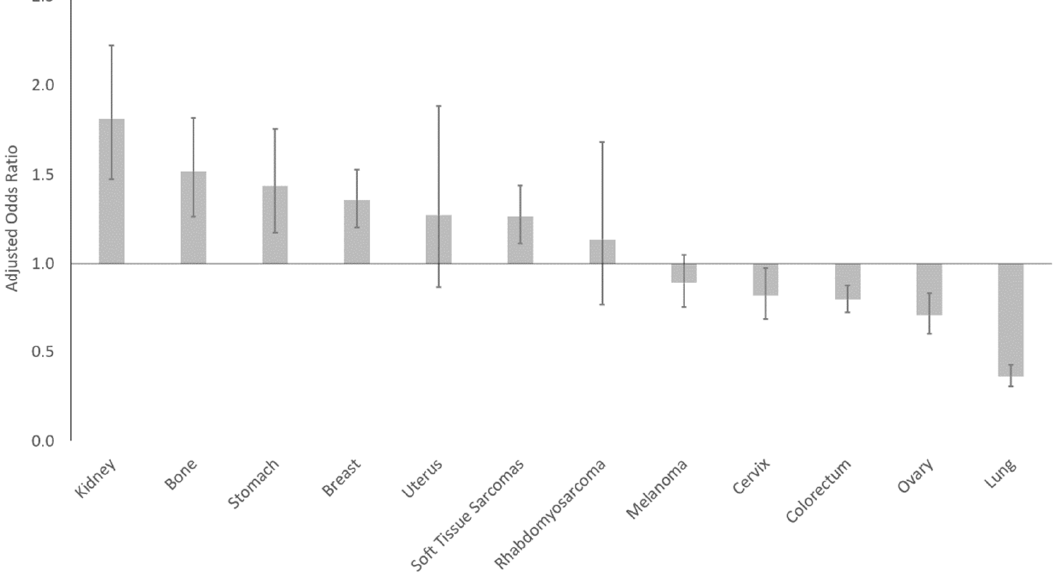
Figure 3 . Risk of metastatic disease for younger AYAs by cancer site. Reference group: older AYAs (30–39 years).